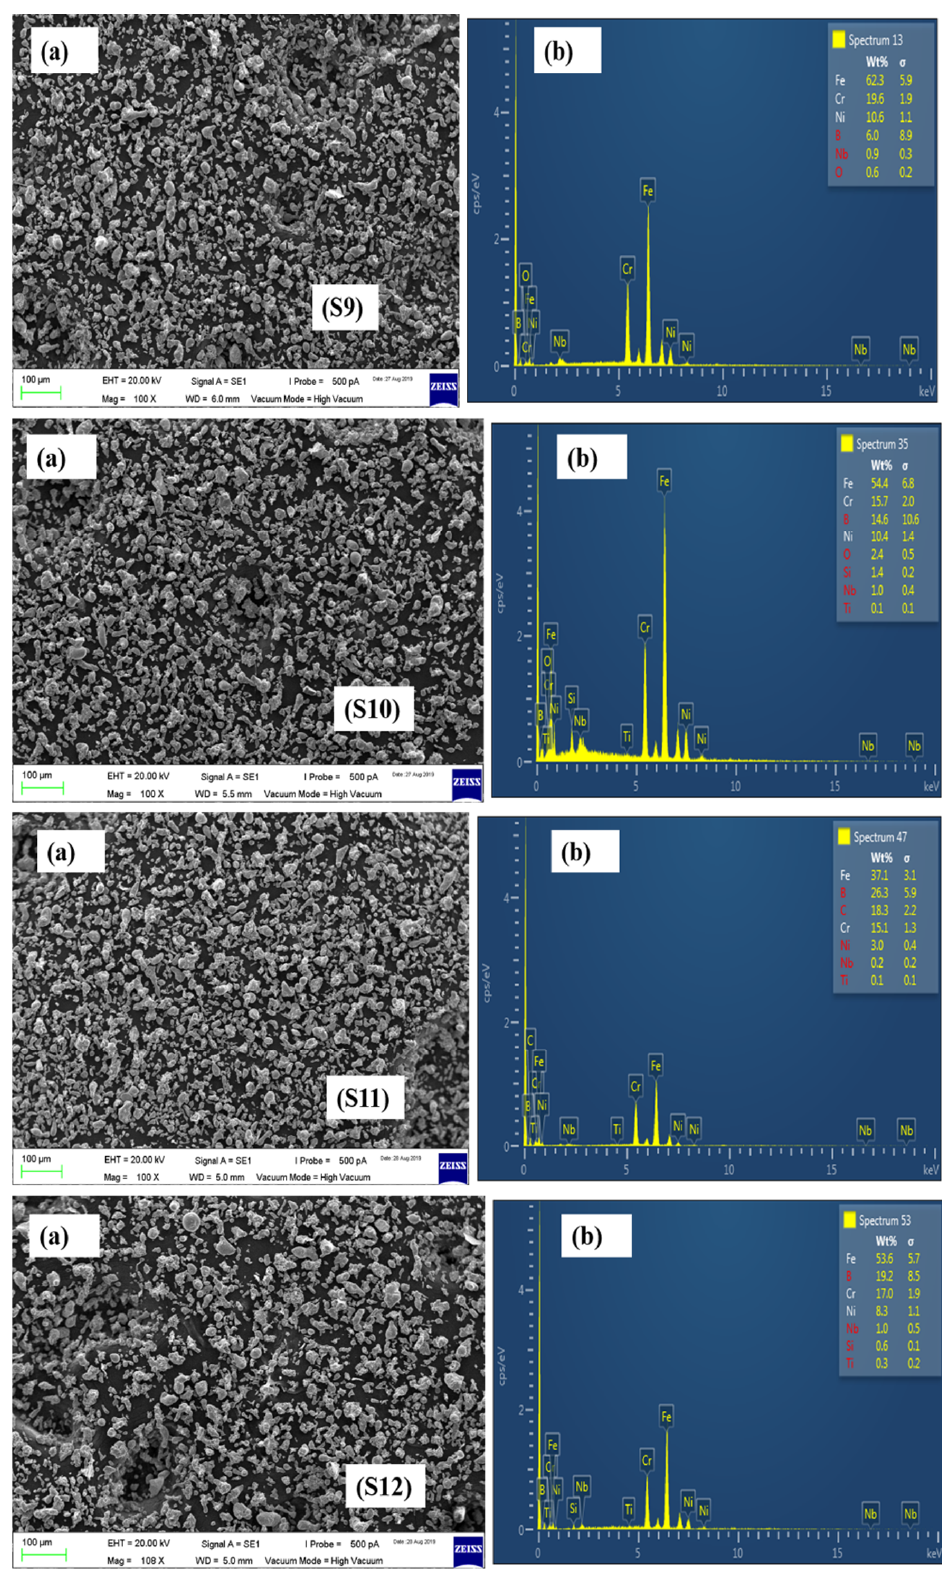
Figure 7. SEM images of S9, S10, S11, and S12 powder formulations.